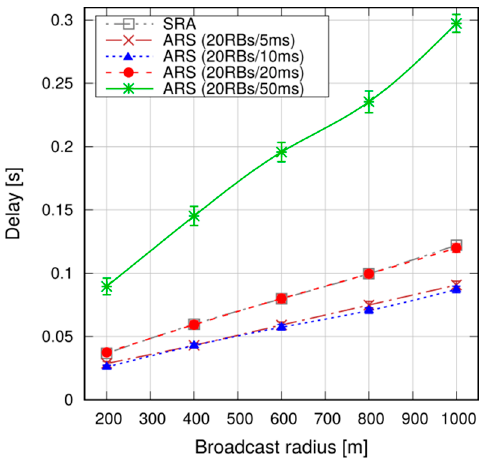
Figure 17. SRA vs. ARS, 95th percentile of delay.